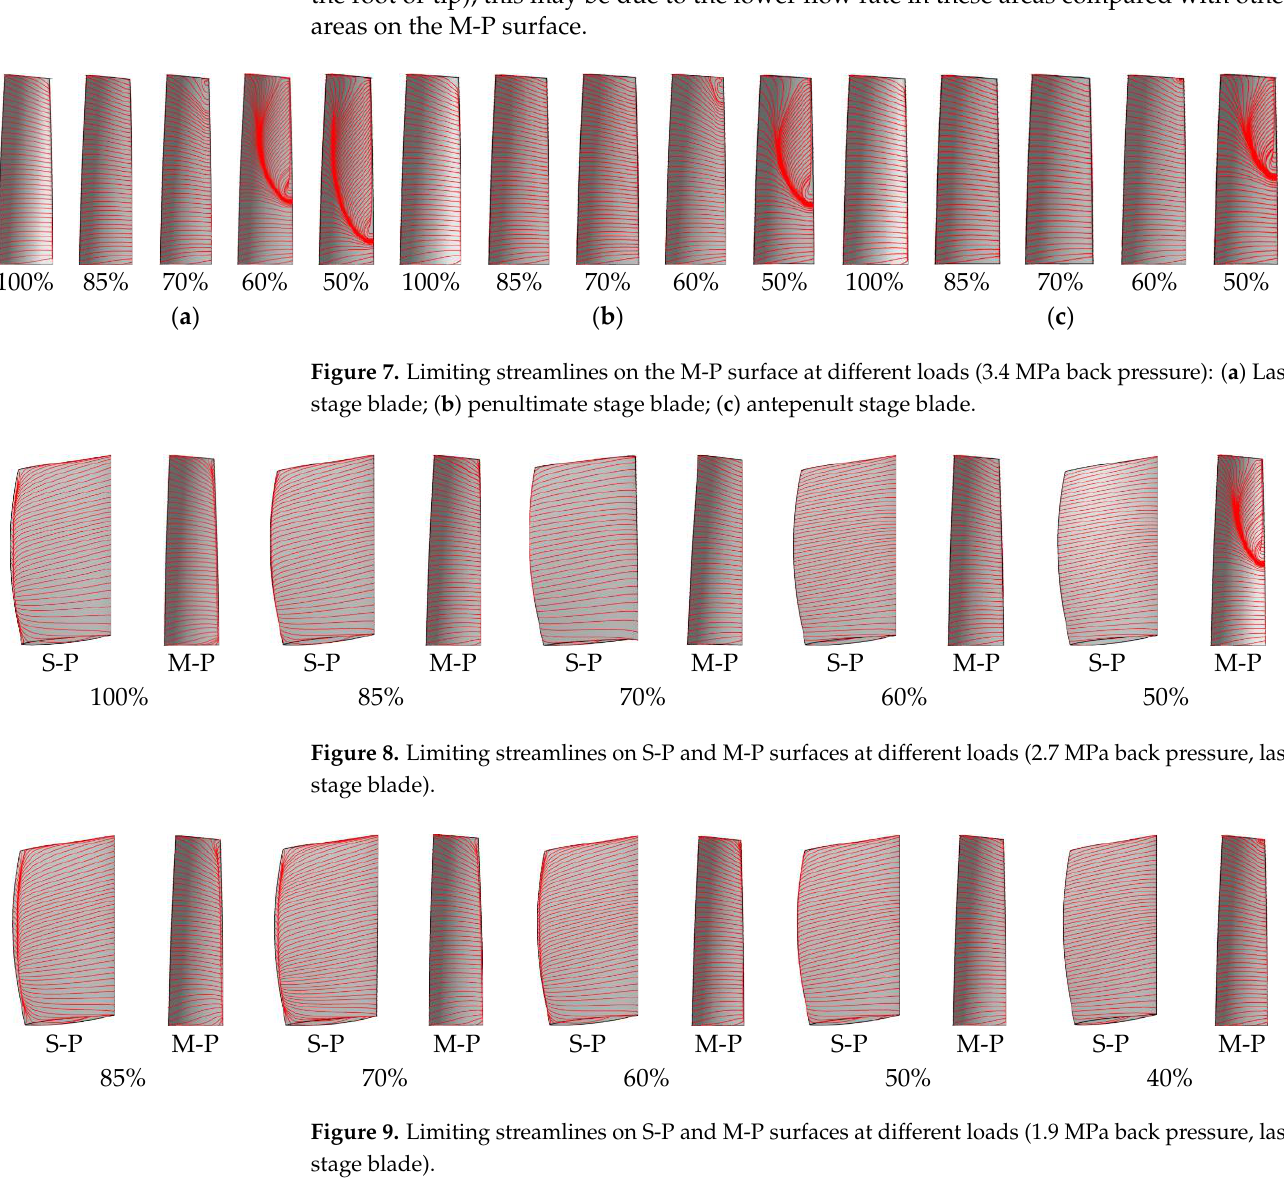
Figure 8. Limiting streamlines on S-P and M-P surfaces at different loads (2.7 MPa back pressure, last stage blade) .